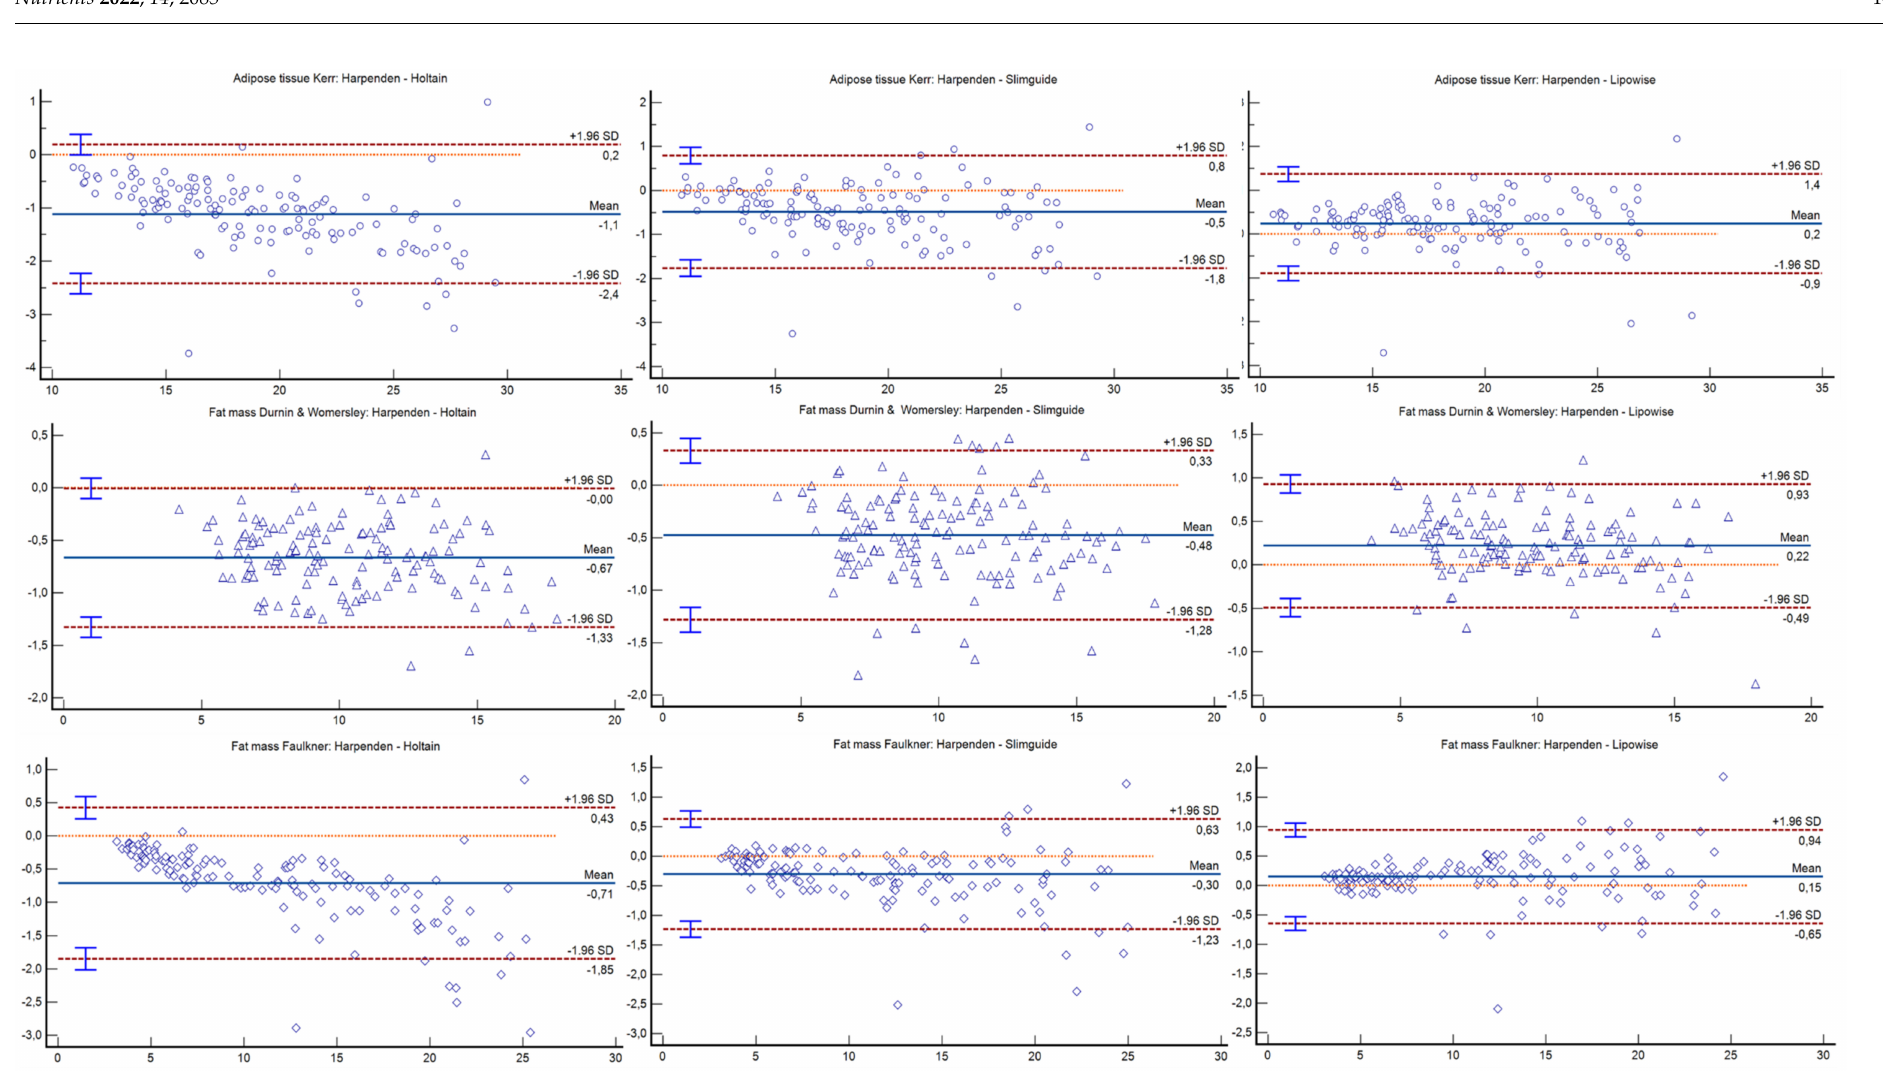
Figure 3. Bland–Altman plot for the kilograms of adipose tissue and fat mass